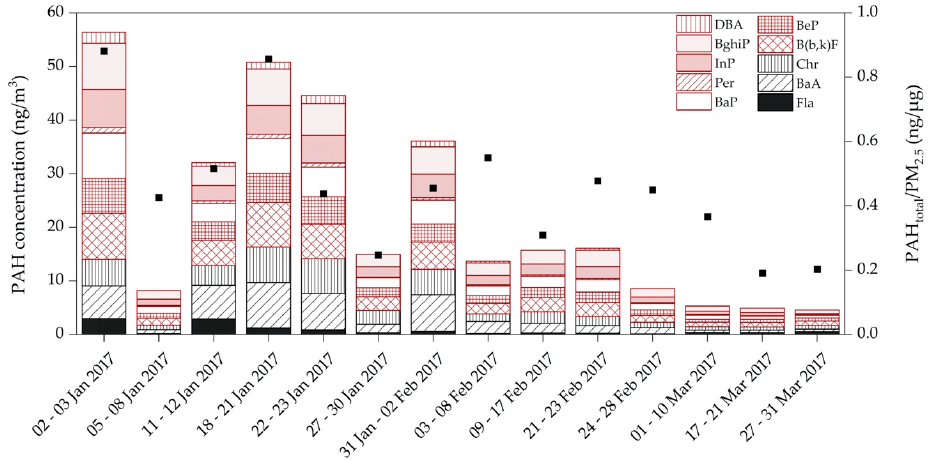
Figure 8. PAH profiles according to their classification of molecular weights. Middle molecular weight (MMW) PAHs are shown in black and high molecular weight (HMW) PAHs in red. Black squares mark the PAH total /PM 2.5 ratios.